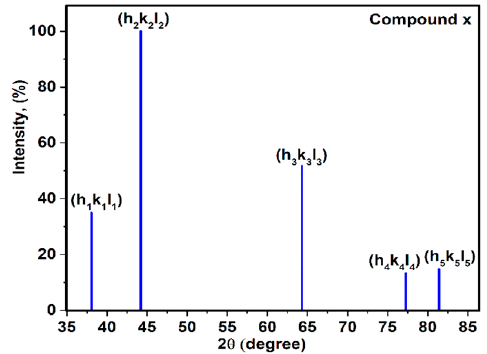
Figure 1. X-ray diffraction of compound x.